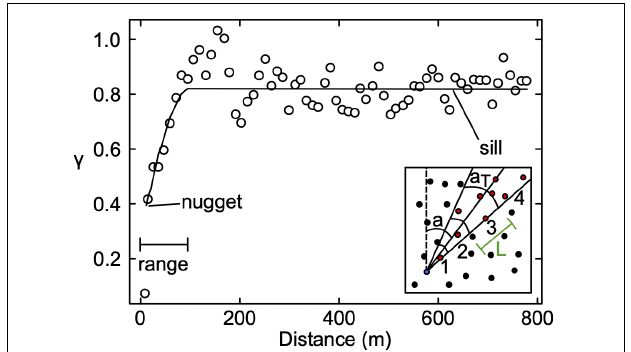
FIGURE 3 | Experimental (65 lags, a lag spacing of 12 m, and an azimuth of 30 ◦ with a total azimuth of 30 ◦ ; white circles) and model (azimuth of 30 ◦ , a sill of 0.82, nugget of 0.30, and a range of 100 m; black line) semi-variogram ( γ is the variogram value, where higher values indicate the data are more correlated) of Tarawera CO 2 flux normal scores used in the sequential Gaussian simulations. The inset illustrates how the variogram is calculated: the circles represent data points at different spatial locations. The spatial correlation of the blue data point to other data points (variogram) can be calculated considering the red data points which are at azimuth a and within total azimuth a T . The lag number ( n ) is indicated in black (1, 2, 3, 4) and correlates to distances of L · n, where L is the lag spacing. This procedure was carried out for all data points to calculate the variogram.